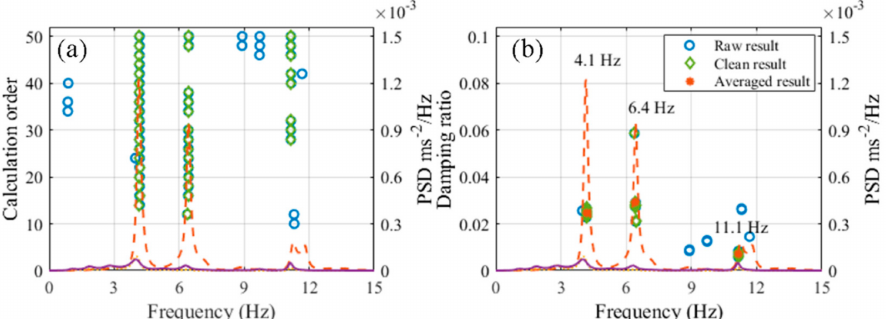
Figure 11. Stabilization diagram using the stochastic subspace identification (SSI) method and identified vibration parameters: ( a ) calculation order as a function of frequency; ( b ) damping ratio as a function of frequency (raw results—prior to pole-picking algorithm; clean results—after application of pole-picking